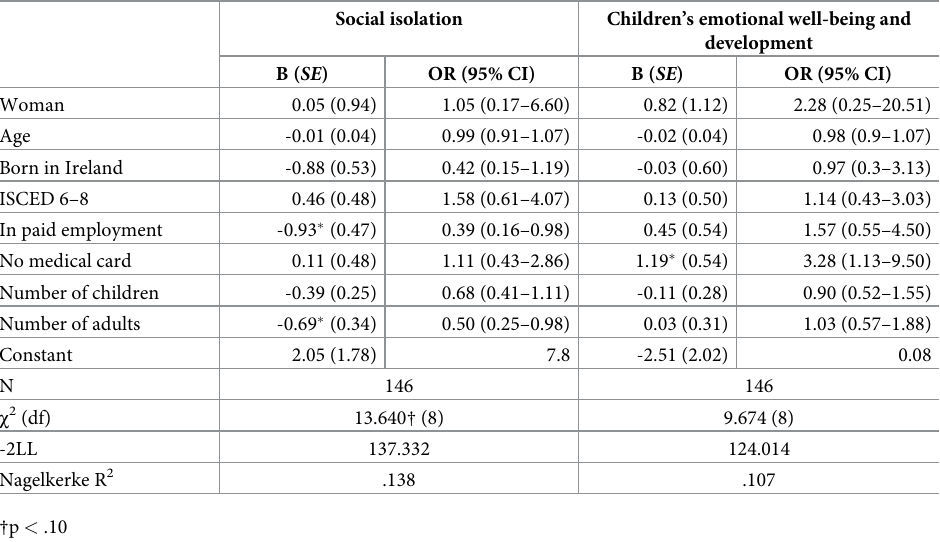
Table 6. Logistic regression analyses for demographics predicting concerns related to the Covid-19 pandemic. Social